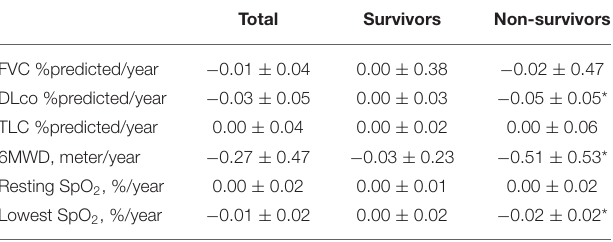
Frontiers in Medicine |